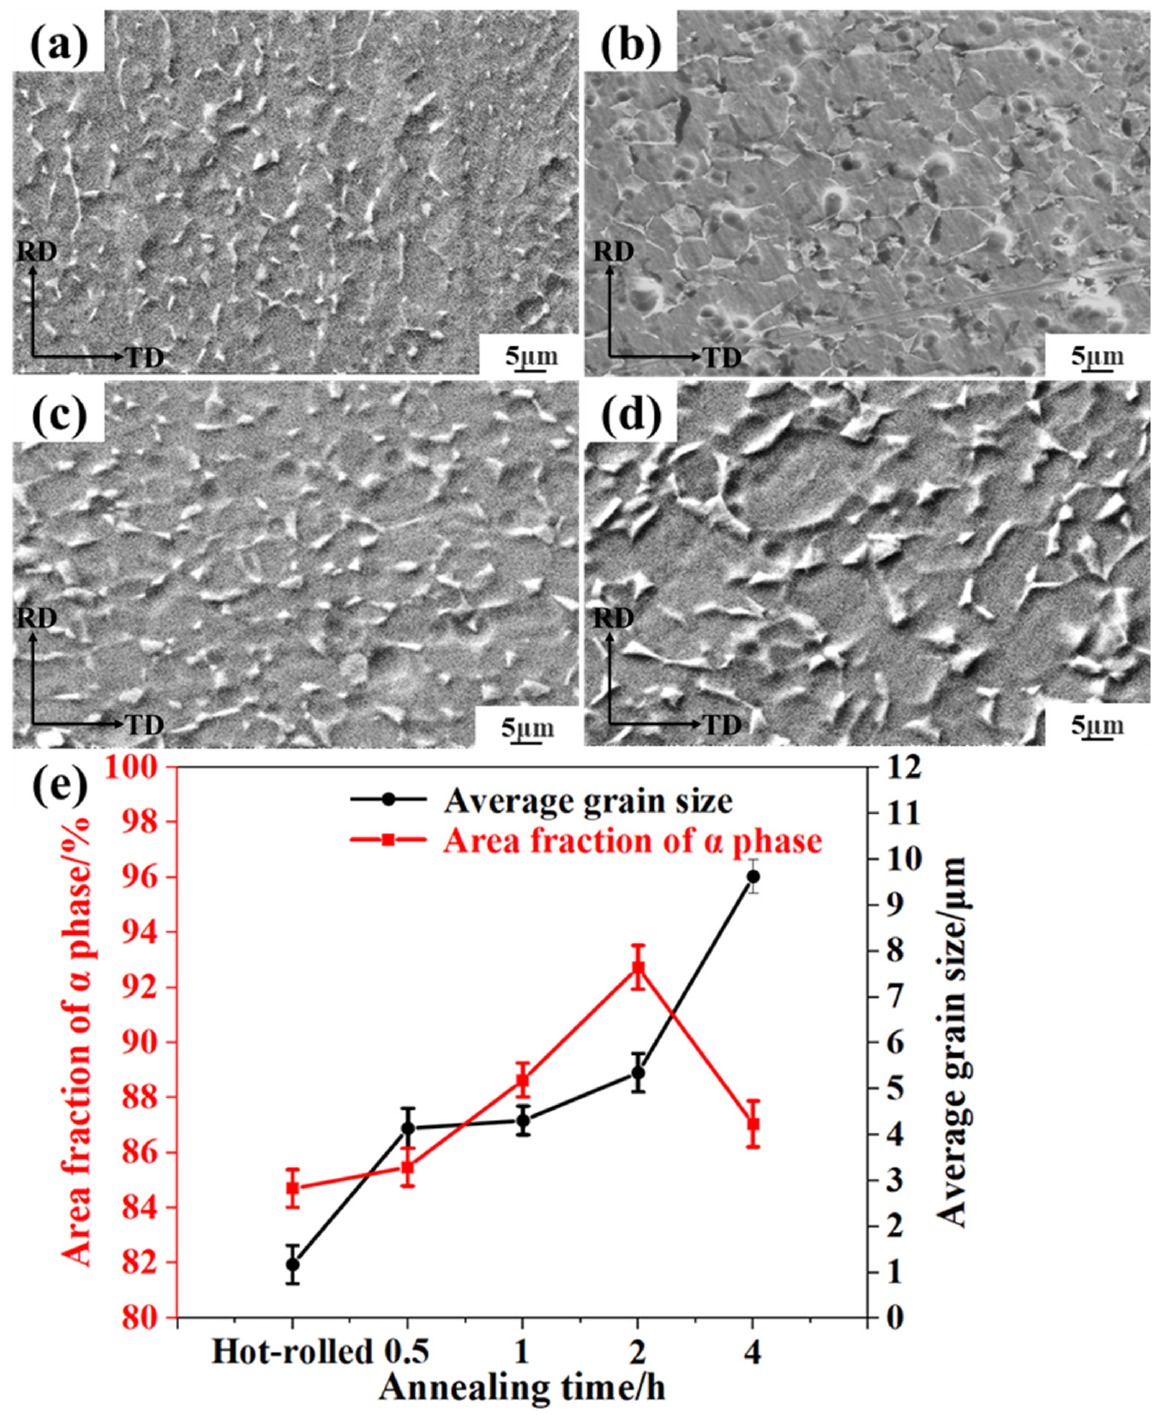
Figure 4. SEM images of annealed TA10 alloy at different times ( a ) 0.5 h, ( b ) 1 h, ( c ) 2 h, ( d ) and 4 h; ( e ) area fraction of α phase and average grain size.